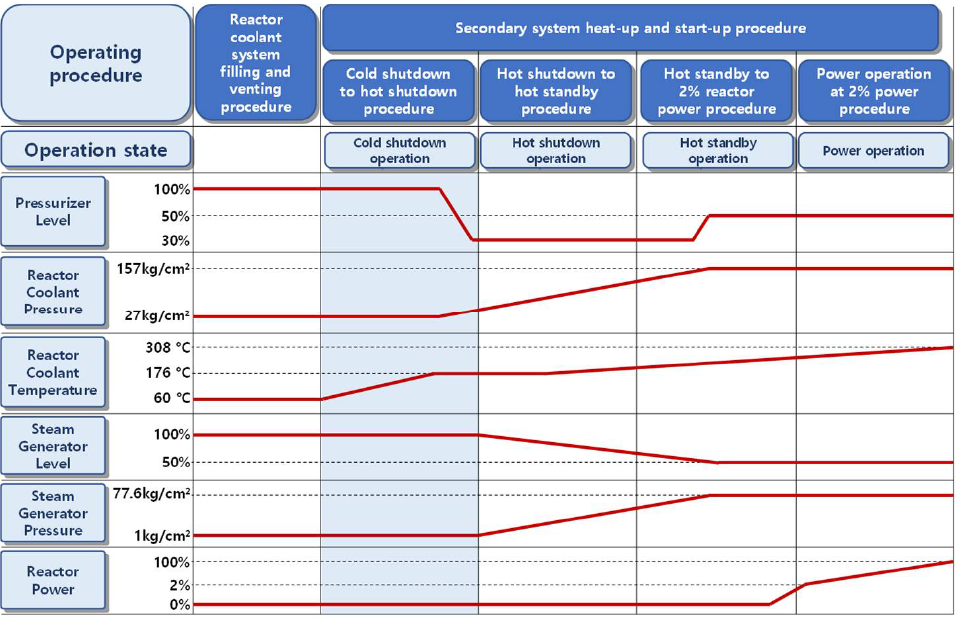
Figure 1. Significant parameters of the startup operation.